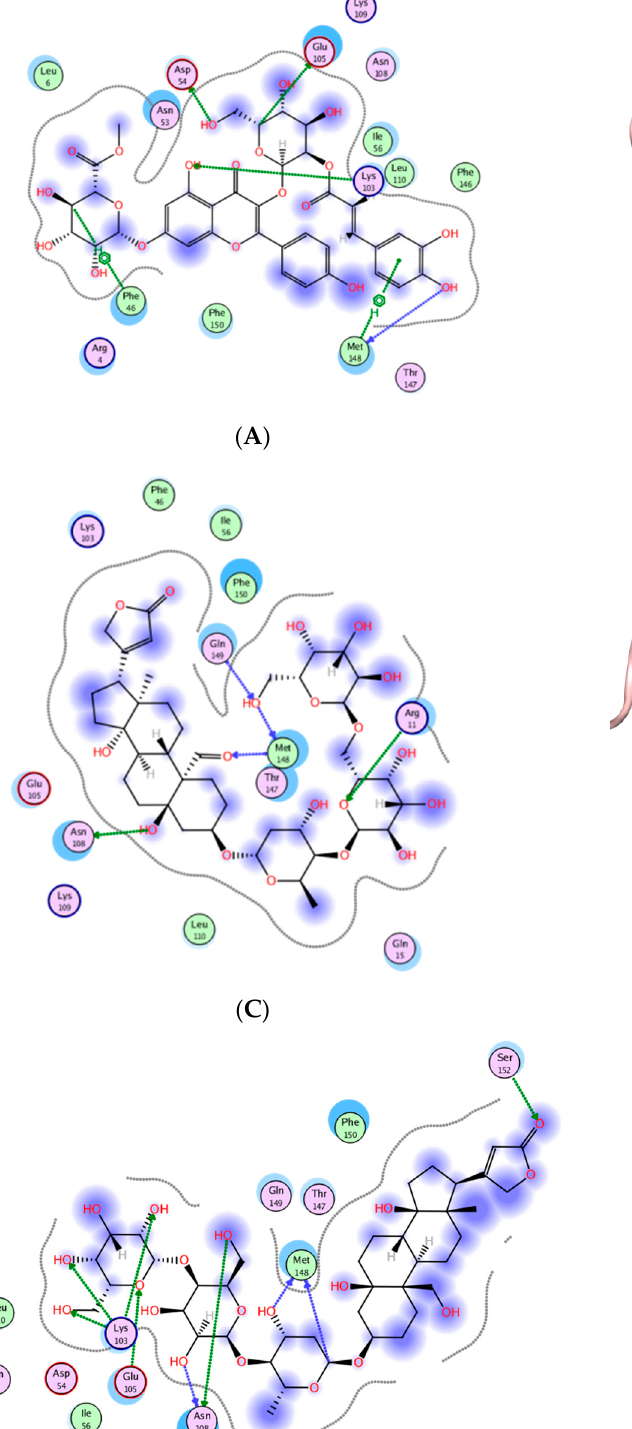
Figure 12. The 2D and 3D molecular docking presentation of the possible binding conformations of 19 ( A , B ), 20 ( C , D ), and 21 ( E , F ) in the TNF- α active site using PDB 2AZ5. The interacting residues are highlighted in the yellow stick model with H-bonds and H-pi interactions are presented as green and red dotted lines, respectively, having their distances illustrated in Å.